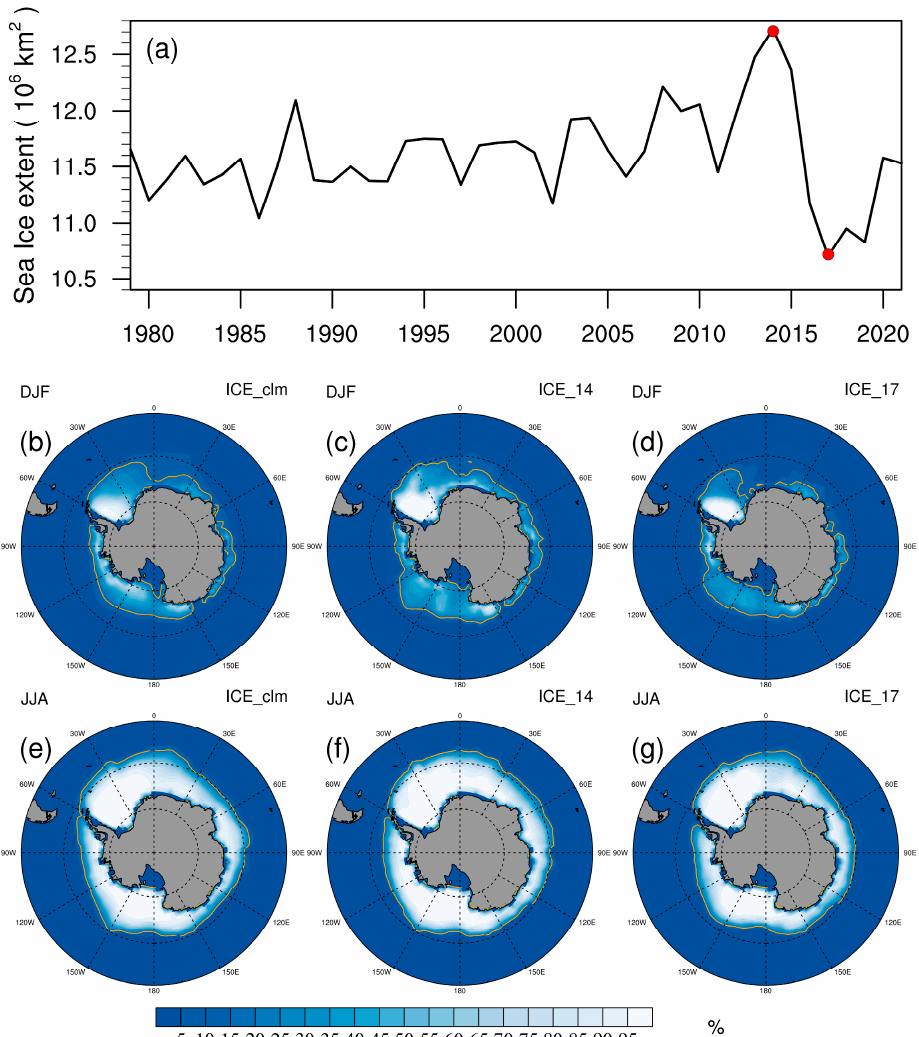
Figure 1. Extent and concentration of Antarctic sea ice. ( a ) Annual-mean Antarctic sea ice extent from 1979 to 2021. Antarctic sea ice concentration averaged between 1981 and 2010 in ( b ) summer and ( e ) winter. Antarctic sea ice concentration in ( c ) summer 2014 and ( f ) winter 2014. Antarctic sea ice concentration in ( d ) summer 2017 and ( g ) winter 2017. The orange line in ( b – g ) represents the edge of the sea ice defined as the contour of 15% ice concentration.